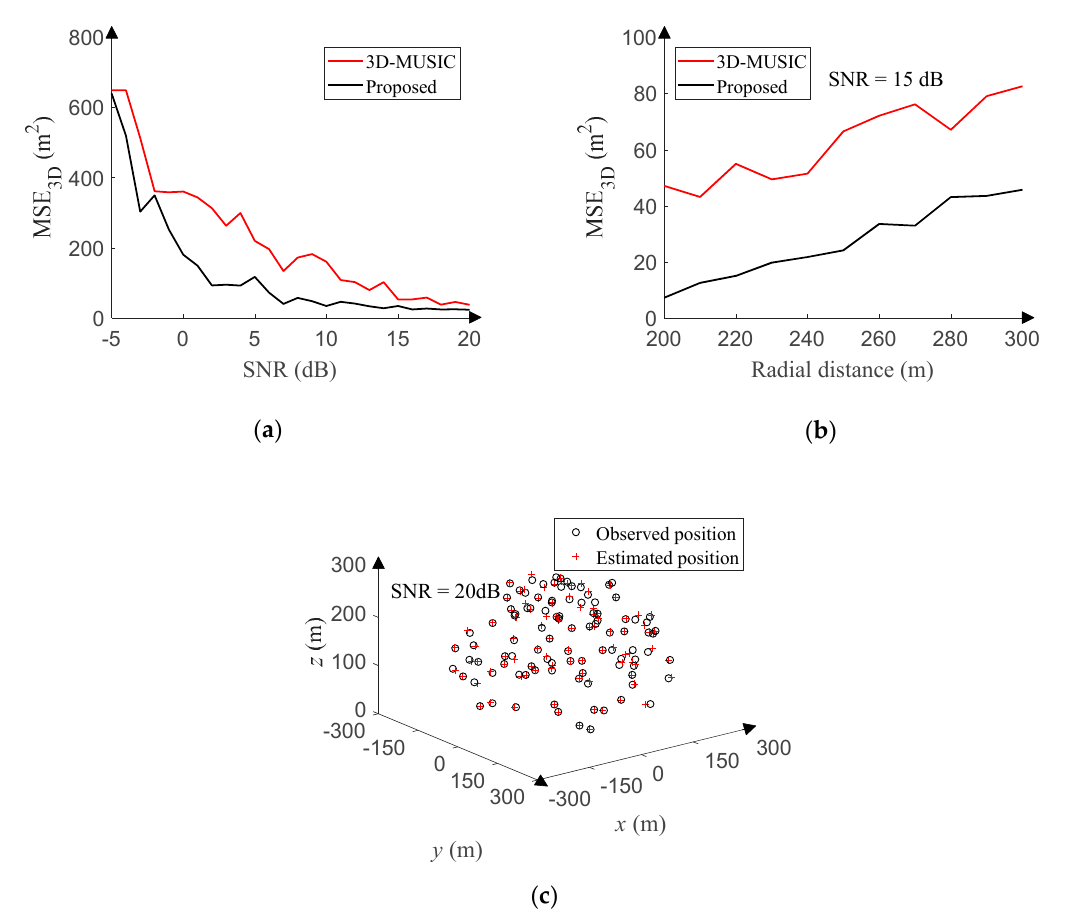
Figure 15. 3D-DOA estimation performance in Gaussian noise. ( a ) MSE versus GSNR. ( b ) MSE versus radial distance. ( c ) Response of the proposed method.